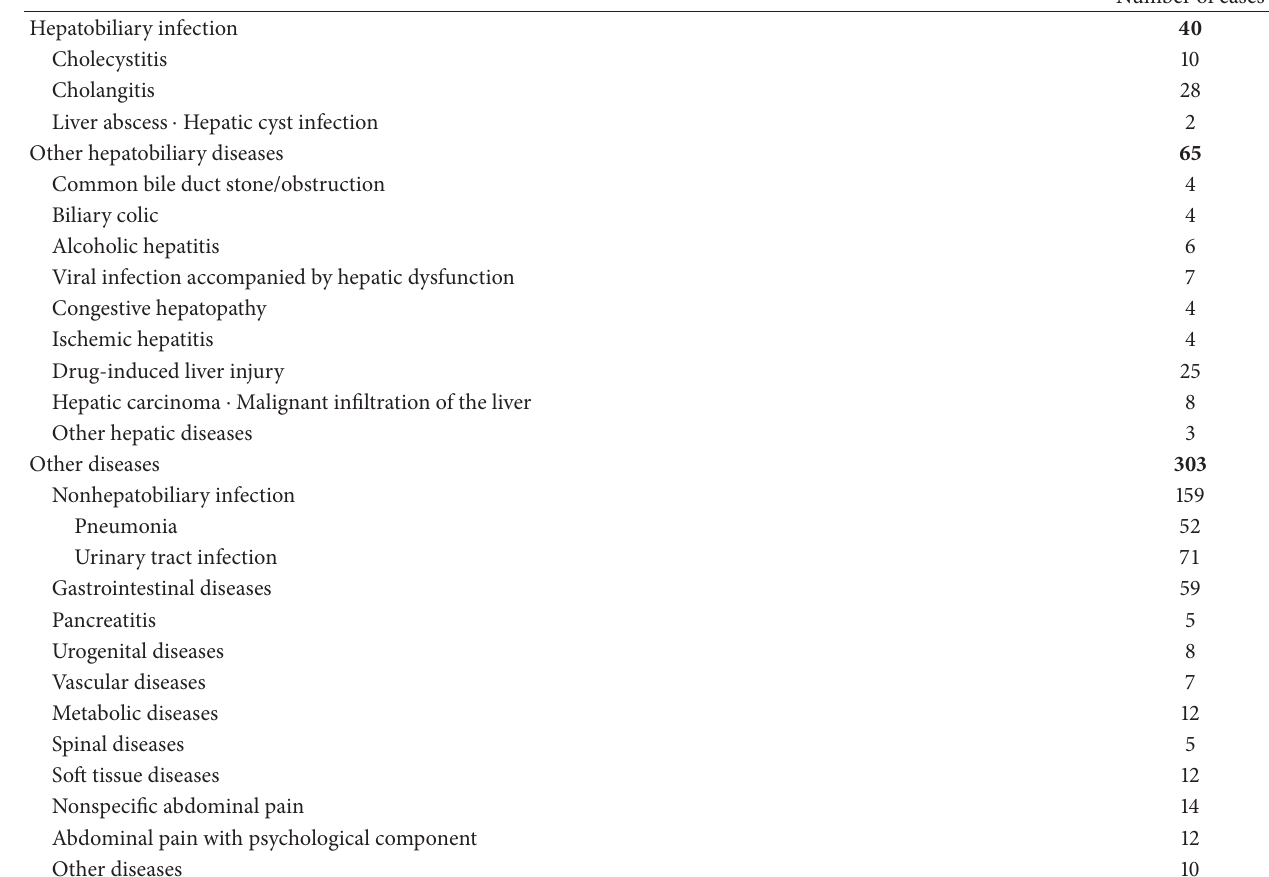
Table 1: Definite diagnoses.